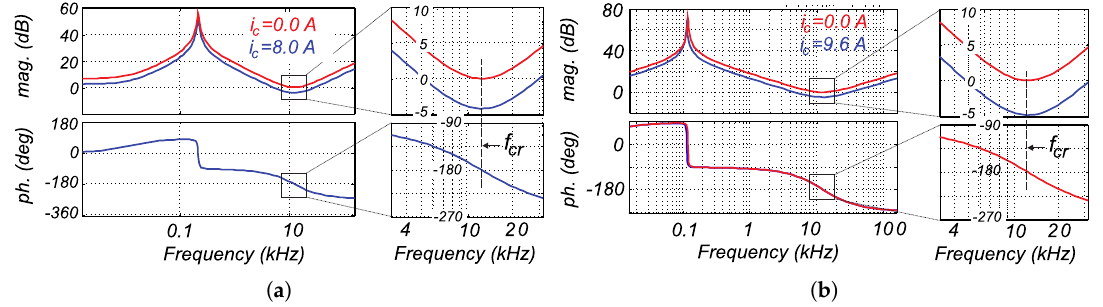
Figure 10. Frequency response, current-programmed mode control, for: ( a ) buck and ( b ) boost converter operation, without (red curve) and with (blue curve) compensating ramp.